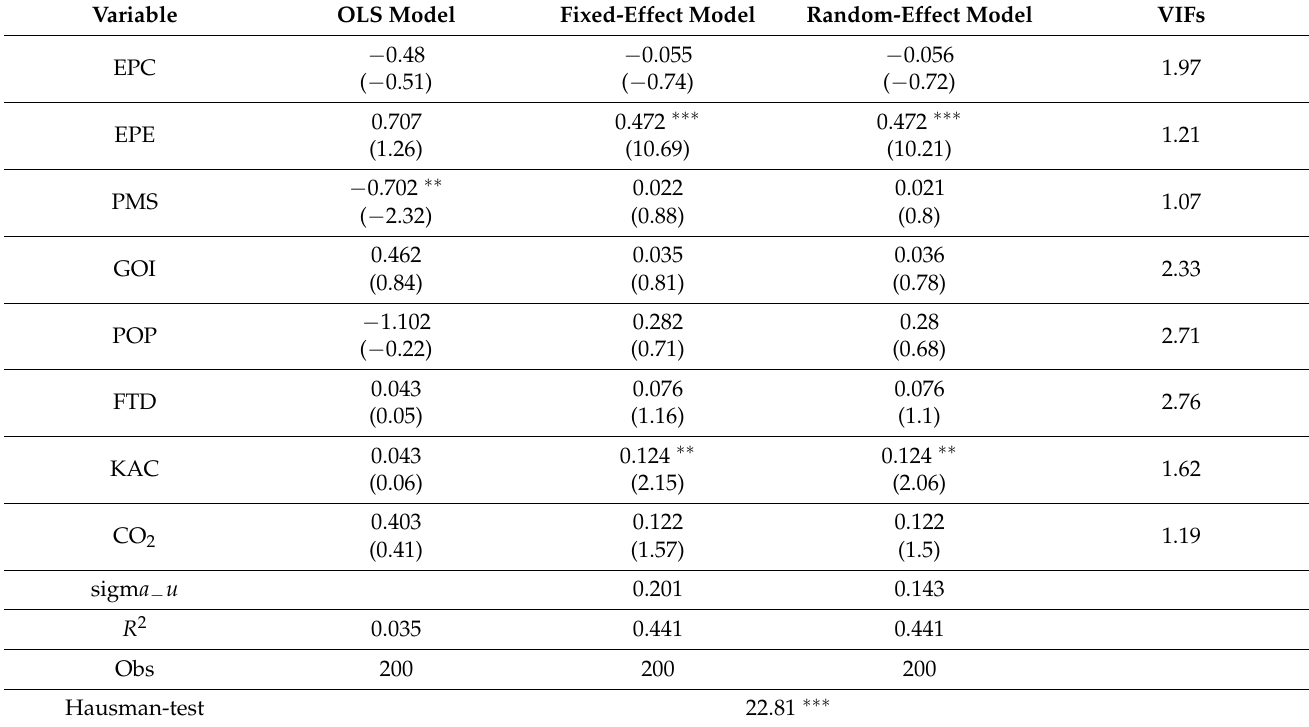
Table 7. Results of the conventional panel econometric